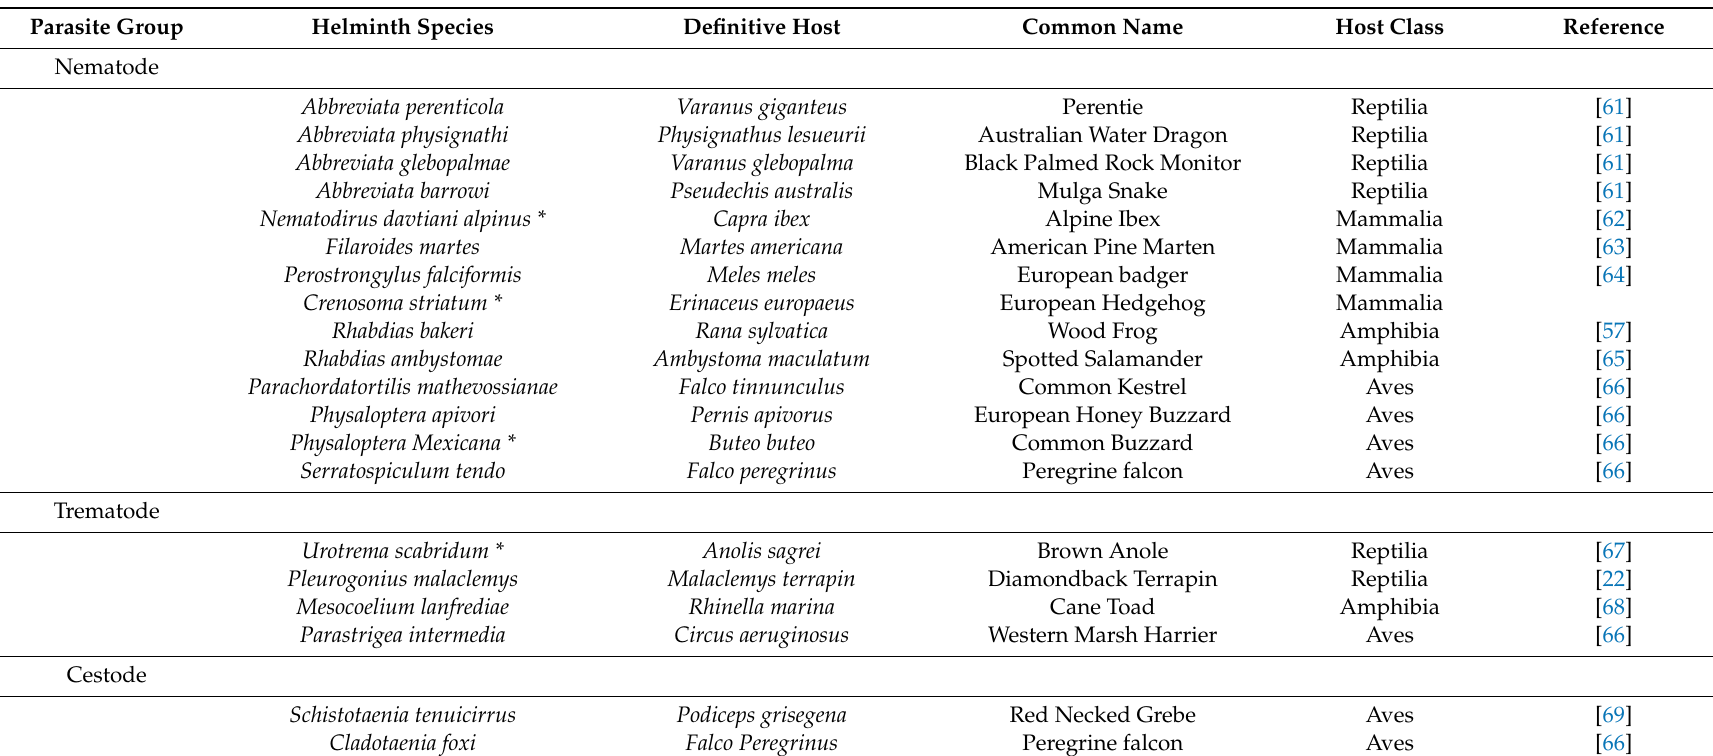
Table 3. Examples of helminth species that to date, have only been identified in a singular definitive